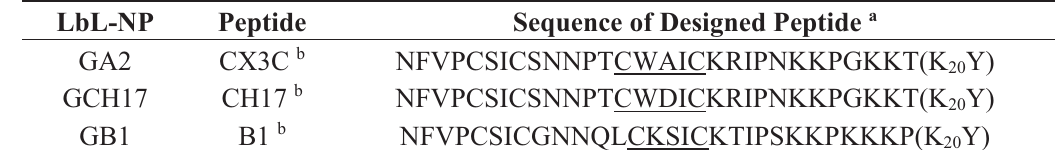
Table 2. Peptides used for the LbL nanoparticle vaccine